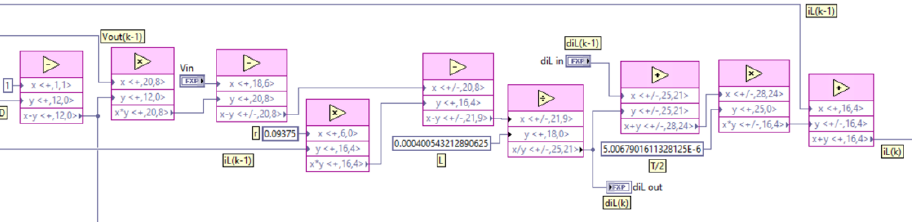
Figure 12. Code for the calculation of i L (k) .